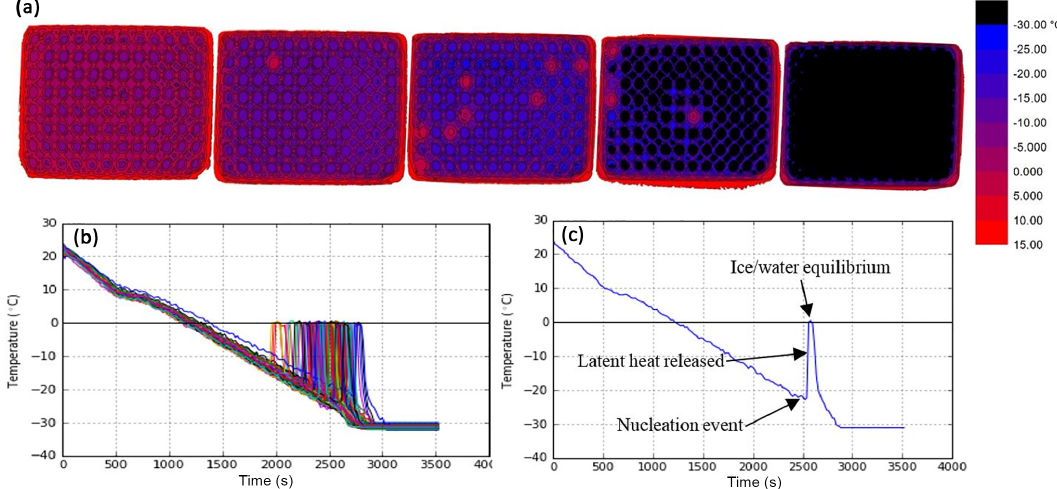
Figure 2. Illustration of the use of the IR camera to measure temperature and freezing events. (a) A sequence of colour maps taken during the course of an experiment. The leftmost image shows the start of an experiment with all droplets unfrozen, moving to all droplets frozen in the rightmost image. Warmer temperatures are represented in red, transitioning to blue for colder temperatures and finally black at − 30 ◦ C and below. Freezing events in individual wells are evident when they warm up to 0 ◦ C. (b) An example of the output of an experiment with the temperature of each of the 96 wells plotted against time. The sharp increases in temperature are related to ice formation. The cooling rate was 1 ◦ Cmin − 1 . The calibration described in Sect. 2.2 was applied here. Note that one well had a higher temperature than the others, likely due to poor thermal contact with the aluminium substrate. By using IR thermometry to measure the temperature of each well individually, such variability is accounted for. (c) Plot of temperature vs. time for a single well within a multiwell plate containing a 50µL aliquot of